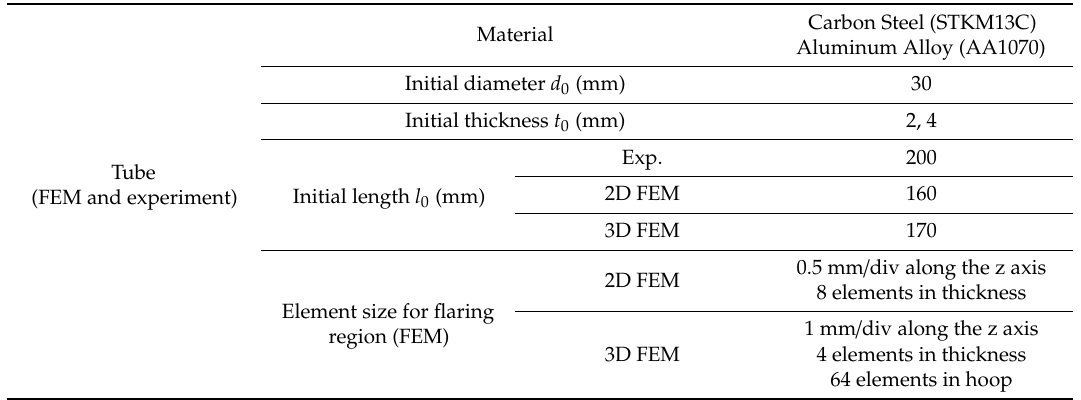
Table 3. Process conditions for the expansion and plug drawing